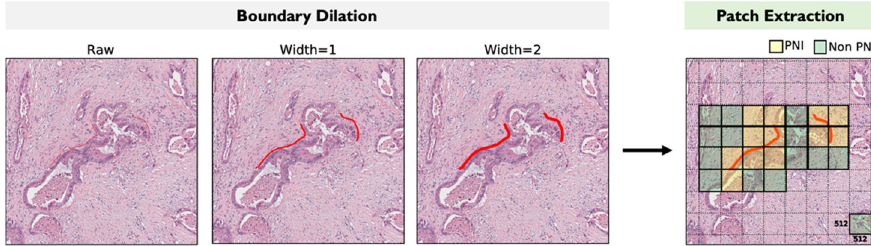
Figure 2. Proposed boundary dilation method and patch extraction procedure.